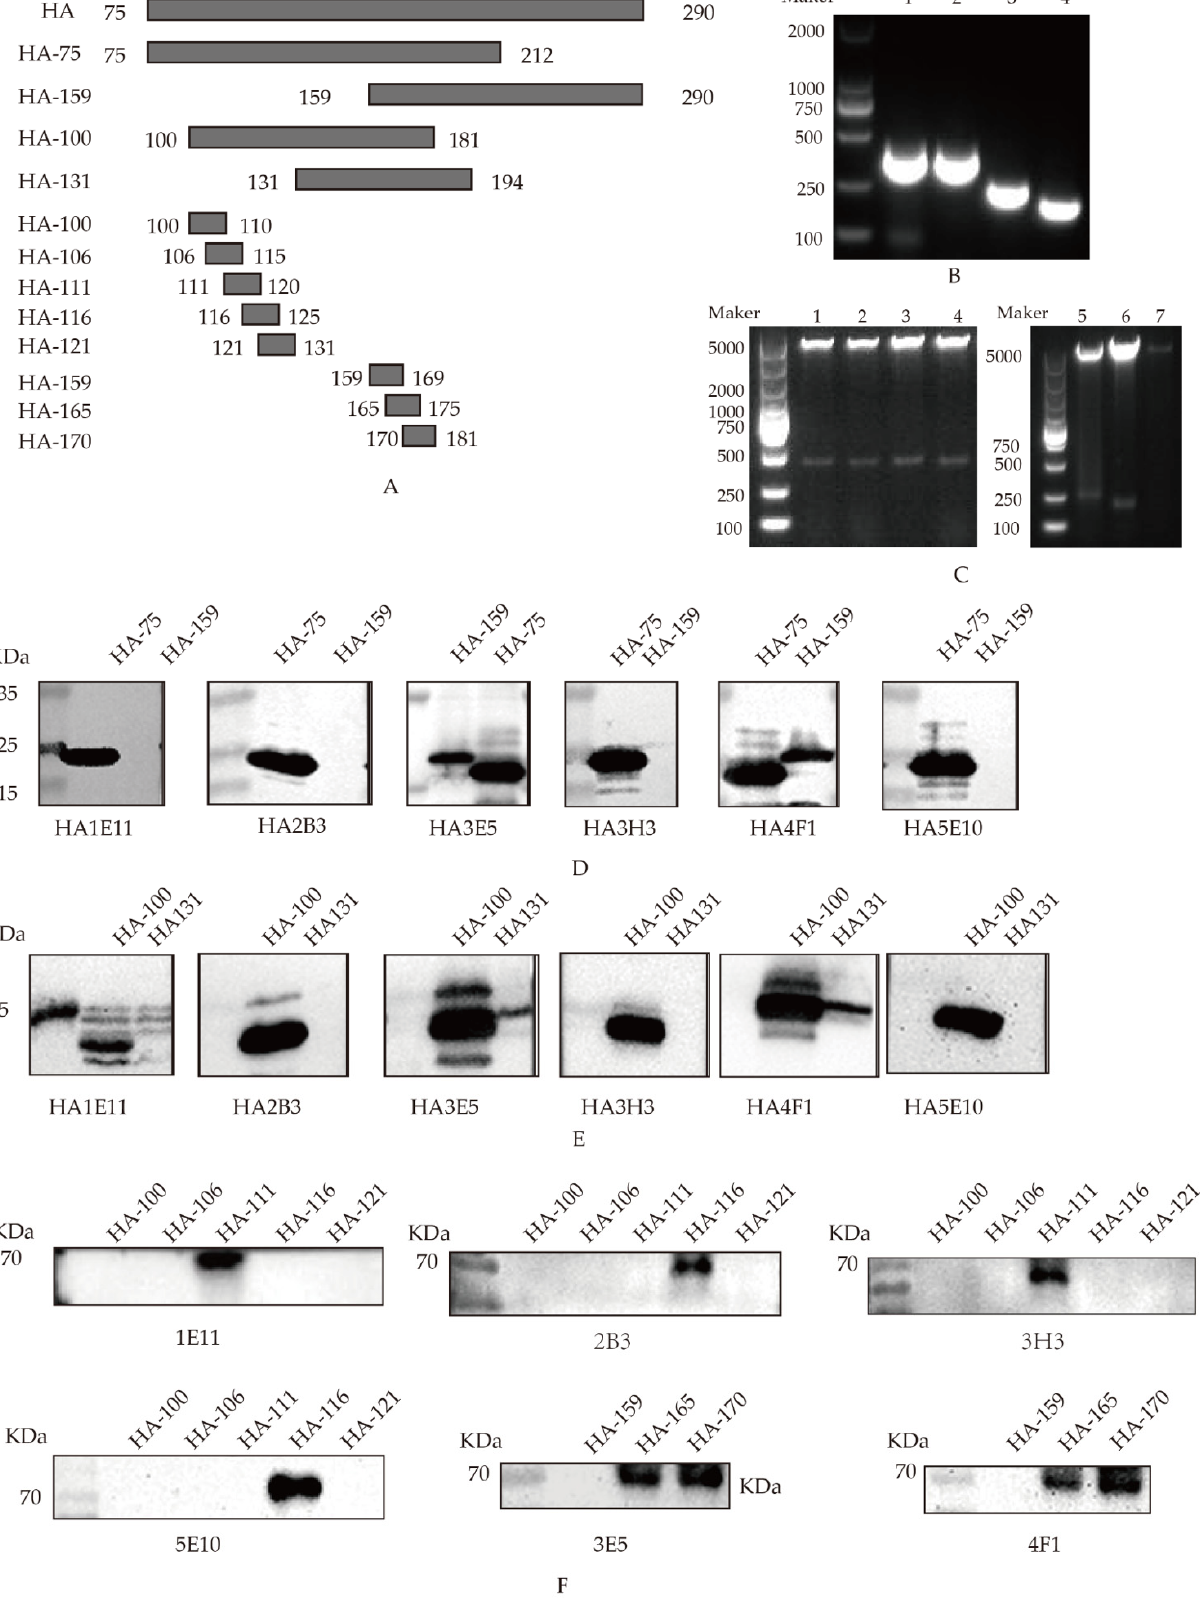
Figure 3. Identification of B cell determinants of mAbs special to HA protein: ( A ) schematic diagram of HA epitope identification; ( B ) PCR amplification. Lane 1, PCR production of HA-75; lane 2, PCR production of HA-159; lane 3, PCR production of HA-100; lane 4, PCR production of HA-131; ( C )